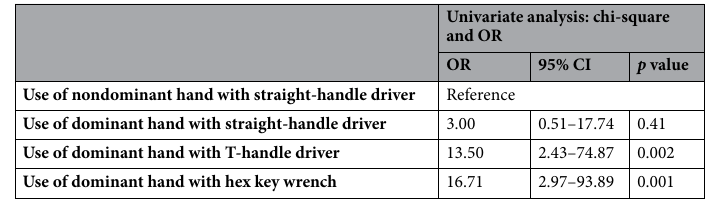
Table 3. Association between the use of a dominant hand and prevention of screw stripping. OR = odds ratio, 95% CI = 95% confidence interval.